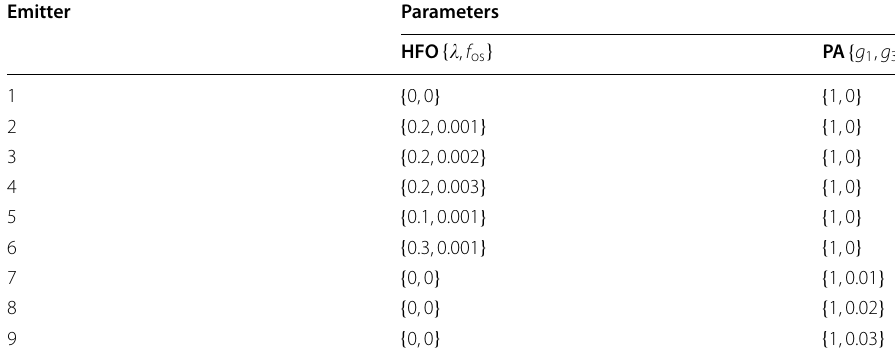
Table 6 Parameters of the simulated emitters